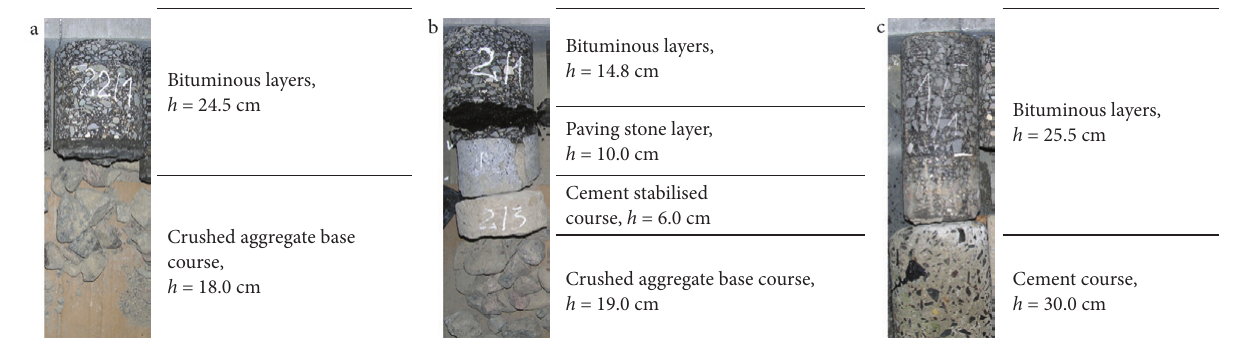
Fig. 2. Example specimen of: a – flexible pavement; b – “mixed pavement”; c – semi-flexible pavement